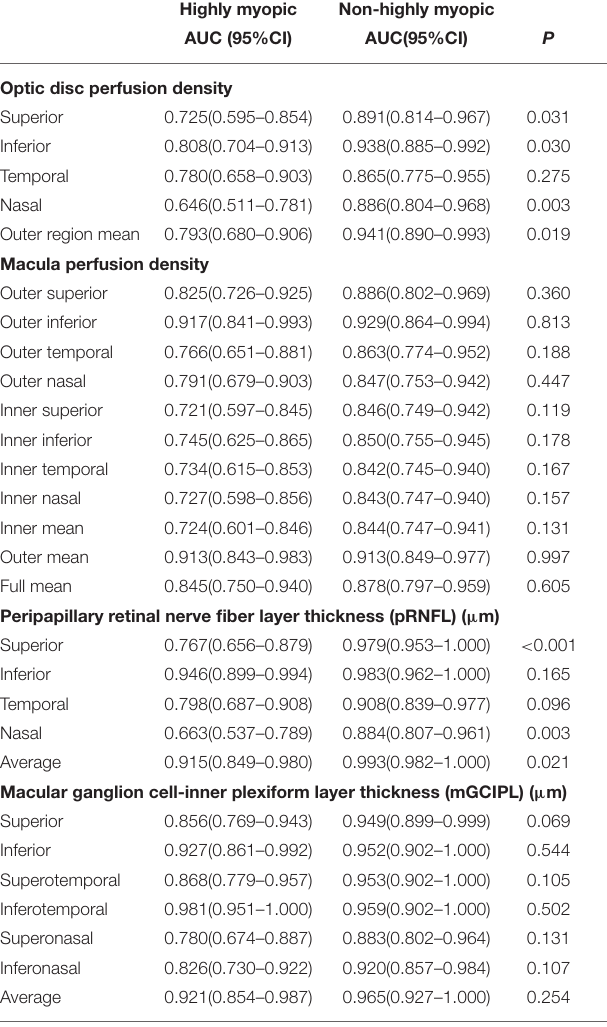
TABLE 3 | Area under the receiver operation characteristic curves (AUC) values in highly and non-highly myopic eyes among normal and glaucomatous eyes.